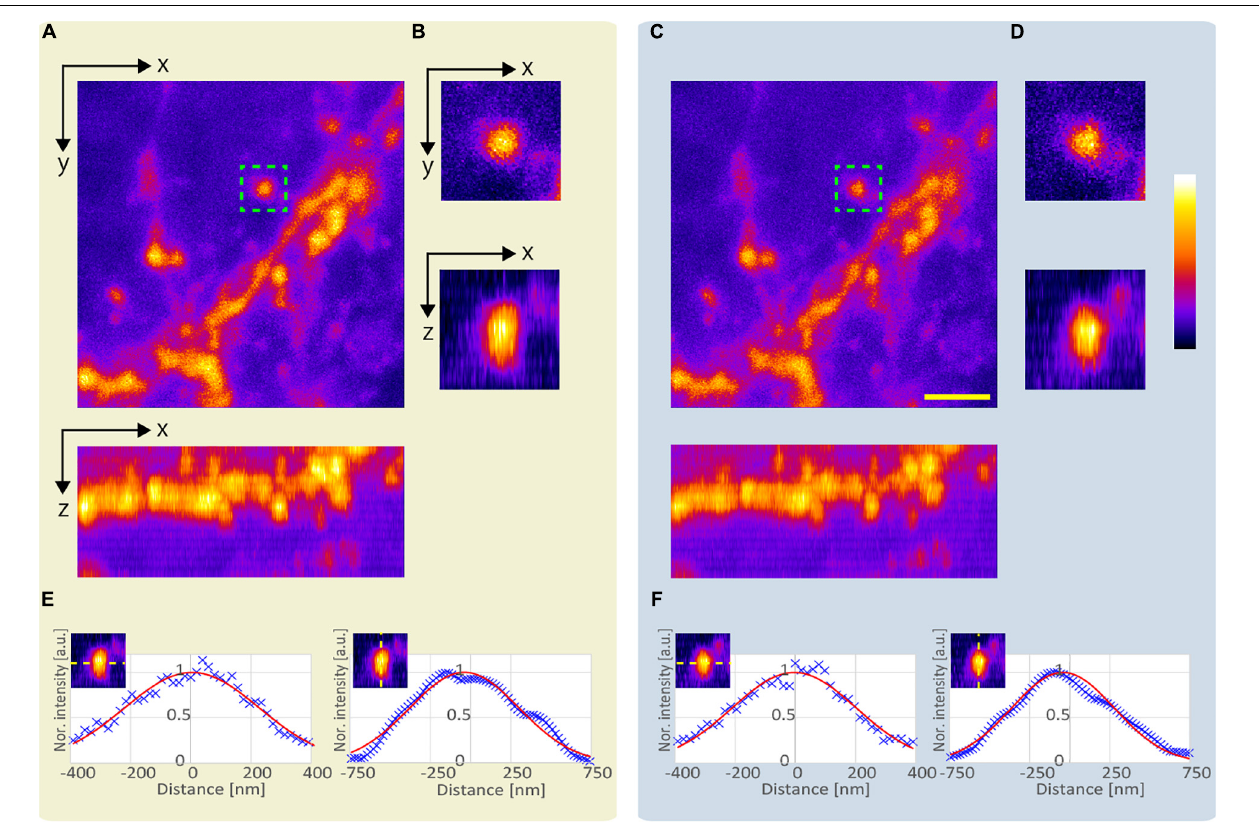
FIGURE 7 | Observation result of the YFP mouse brain at an optical depth from 19.6 to 23.7 µ m. (A) Images obtained using the APV excitation beam. Top: x-y stacked image. Bottom: x-z projected image. (B) Magnified views of the area surrounded by green dash squares in panel (A) . (C) Images obtained using the AMAPV excitation beam. (D) Magnified views of the area surrounded by green dash squares in panel (C) . (E,F) Line profile and Gaussian fitting result. The excitation beam intensity under the objective lens was (A) 53.3 mW and (C) 71.4 mW. Scale bar: 2 µ